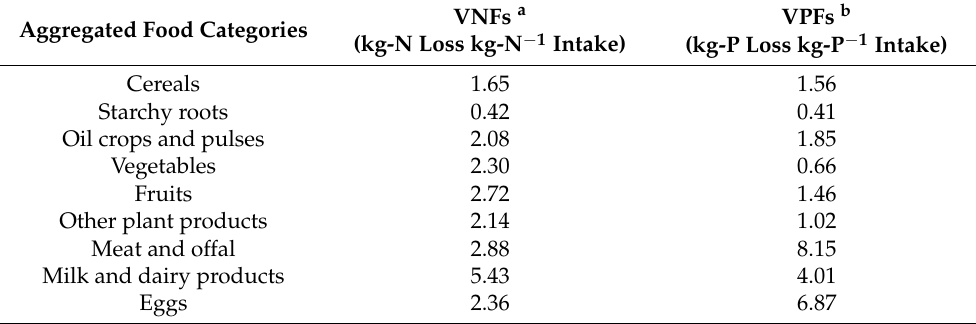
Table 1. Domestic virtual nitrogen and phosphorus factors (VNFs and VPFs) of India in 2013.